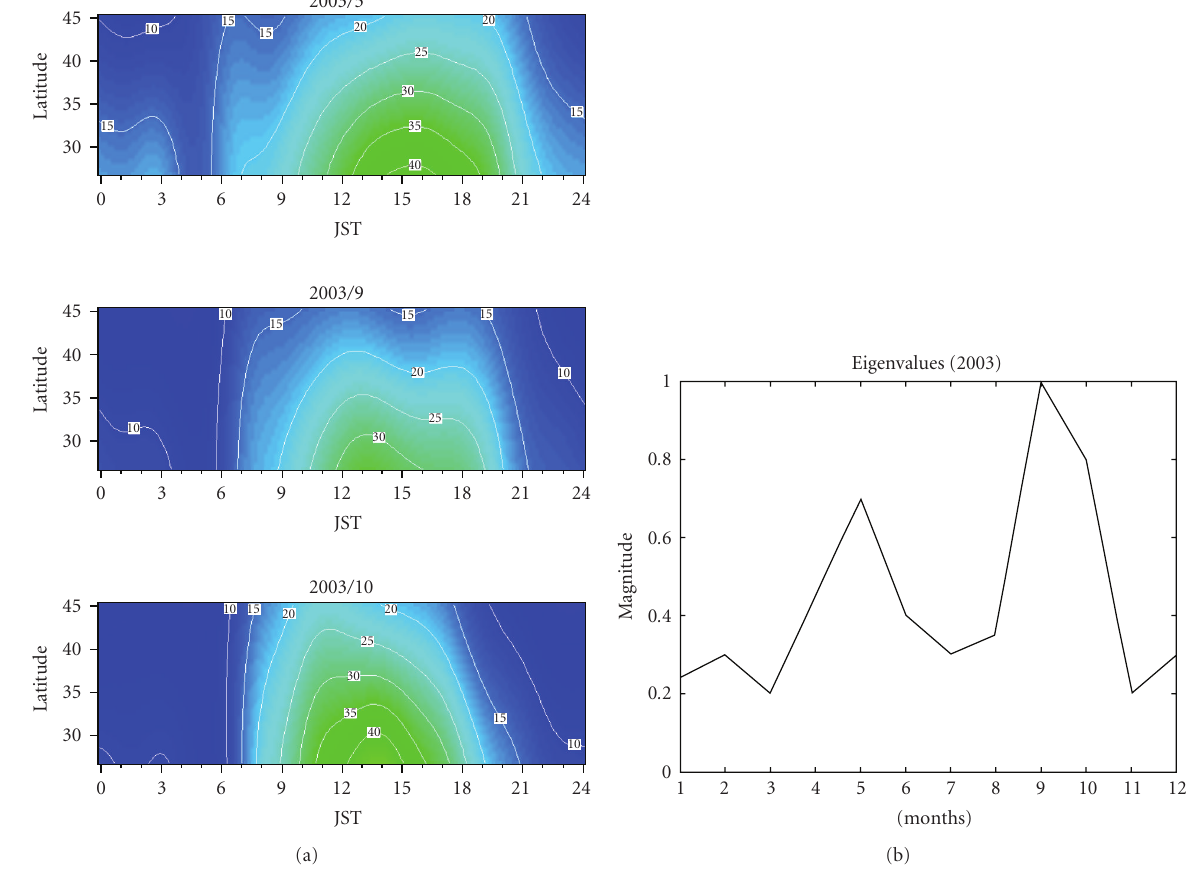
Figure 3: (a) shows the latitude-time TEC records in Japan for 2003 (Unit: TECu). (b) shows 12 principal eigenvalues in 2003. Three larger principal eigenvalues are represented in May, September, and October in which four earthquakes occurred on May 26, September 25, October 8, and October 31 (Table